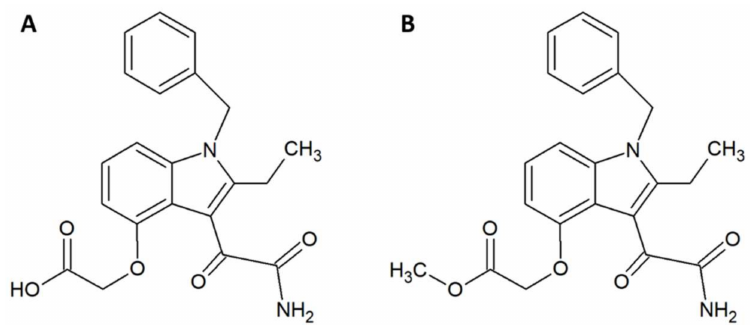
Figure 1. Chemical structures of ( A ) varespladib and ( B ) methyl-varespladib.